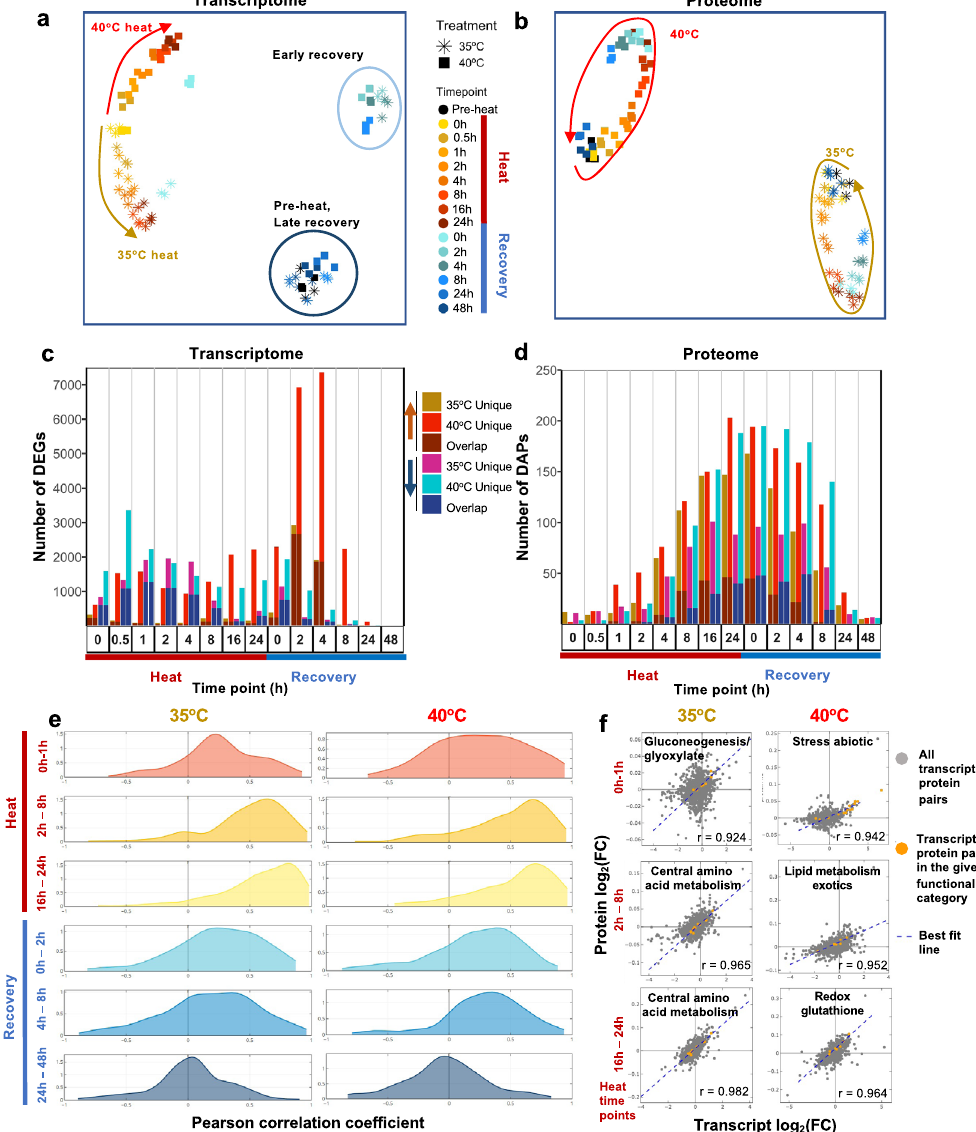
Fig. 2 Transcriptomics and proteomics revealed distinct and dynamic responses during and after heat treatments of 35°C and 40°C. a Uniform Manifold Approximation and Projection (UMAP) of Transcripts Per Million (TPM) normalized RNA-seq read counts and (b) UMAP of normalized protein intensities. Each data point represents all normalized counts from a single sample. Stars and squares represent algal samples with heat treatments of 35°C or 40°C, respectively. Different colors represent different time points. Brown and red arrows show the movement through time of the 35°C and 40°C treated samples, respectively. c , d Number of unique or overlapping Differentially Expressed Genes (DEGs) and Differentially Accumulated Proteins (DAPs) with heat treatment of 35°C or 40°C at different time points, respectively. Each time point has four bars: the fi rst bar represents genes up-regulated in 35°C, the second represents genes up-regulated in 40°C, the third represents genes down-regulated in 35°C, and the fourth represents genes down-regulated in 40°C. The bottom portion of the stacked bars represents genes/proteins that are differentially expressed in both treatment groups and the top portion represents genes that are uniquely differentially expressed in the given treatment group at that time point. Signi fi cant differential expression in transcriptome data was de fi ned as absolute values of log 2 (fold-change, FC) > 1, false discovery rate (FDR) < 0.05, and absolute difference of TPM normalized read counts between treatment and pre-heat control ≥ 1. Signi fi cant differential accumulation of proteins was de fi ned by Dunnett ’ s FWER < 0.05. e Analysis of correlation between transcripts and proteins revealed overall rising positive correlation during the heat treatment and a decreasing correlation during recovery. The time points were subdivided into three heat (red labels) and three recovery (blue labels) windows for 35°C (left) and 40°C (right) treated samples. The density plots of Pearson correlation coef fi cients between the fold-changes of transcripts and proteins are shown. X, Pearson correlation coef fi cient. Y, frequency density. Time points during heat: 0 h, reach high temperature of 35°C or 40°C; 1 h, heat at 35°C or 40°C for 1 h, similar names for other time points during heat. Time points during recovery: 0 h, reach control temperature of 25°C for recovery after heat; 2 h, recovery at 25°C for 2 h, similar names for other time points during recovery. See Supplementary Fig. 7 for more information. f Scatter plots of all transcript-protein pairs at 35°C (left) and 40°C (right) for the three heat time point bins shown in ( e ). X and Y, transcript and protein log 2 FC, compared with pre-heat, respectively. Transcript-protein pairs are shown as gray dots. Best fi t lines are shown in blue. The Pearson correlation coef fi cient is shown at the bottom right corner of each scatterplot. Transcript-protein pairs belonging to MapMan functional categories with the highest Pearson correlation coef fi cient in the given time point bin are shown in orange. See the interactive fi gures in Supplementary Data 9: transcripts/proteins